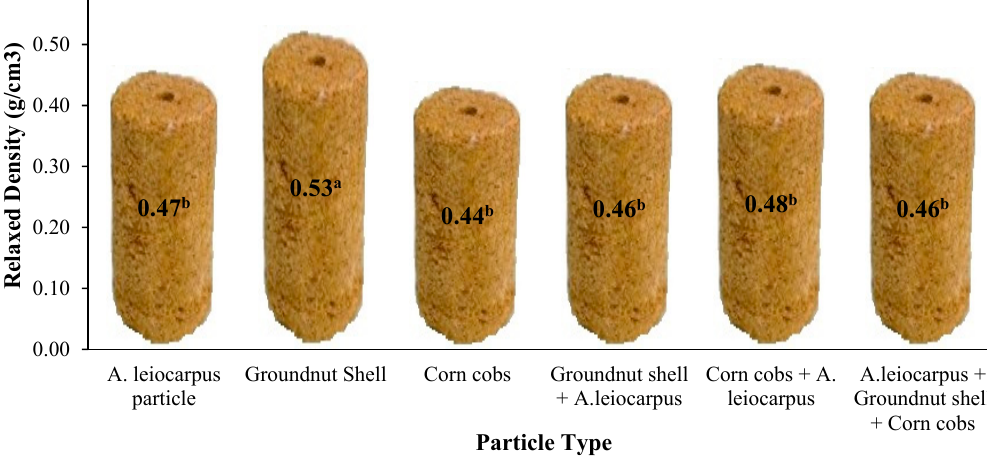
Figure 4. Mean effect of treatments on density (g/cm 3 ) of briquette. Means in the same bar having the same superscript are not significantly different ( p ≥ 0.05).